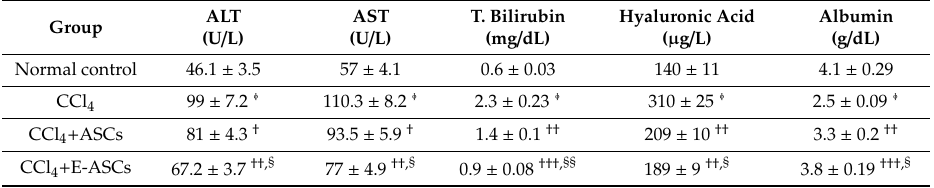
Table 1. Serum levels of the biochemical parameters investigated for the different groups.